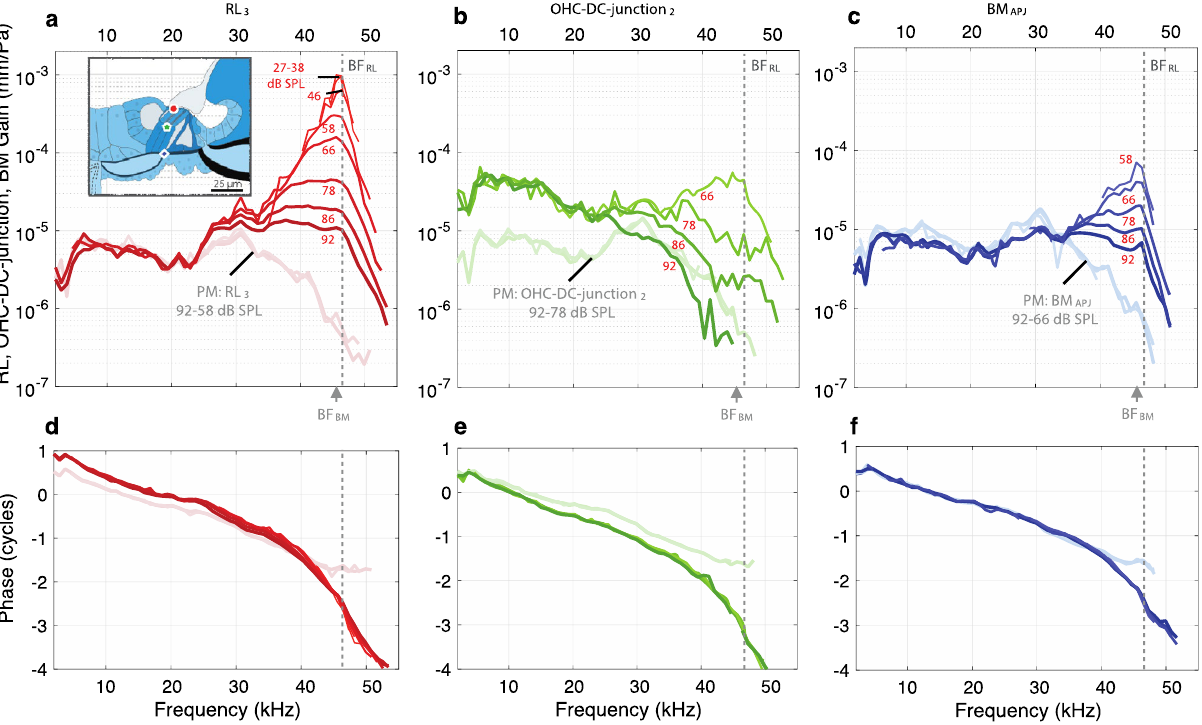
Figure 10. In vivo (darker colors) and PM (faded colors) gain comparisons across different OoC structures along a transverse direction, for specimen G637. ( a–c ) The respective gain magnitudes of RL 3 (red), OHC-DC- junction 2 (green), and BM APJ (blue), all relative to the sound pressure (in units of mm/Pa). The inset drawing in panel ( a ) shows the measurement locations for RL 3 (red circle), OHC-DC-junction 2 (green pentagon), and BM APJ (blue diamond). ( d–f ) The phase responses corresponding to ( a–c ). The available stimulus levels vary across the structures due to different signal-to-noise